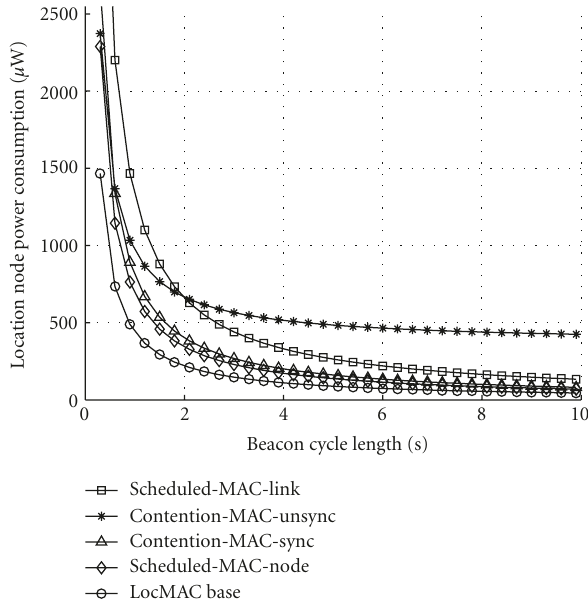
Figure 14: Power consumption of scheduled-MAC-link, conten- tion-MAC-unsync, contention-MAC-sync, scheduled-MAC-node, and LocMAC base as a function of beacon cycle length with static location